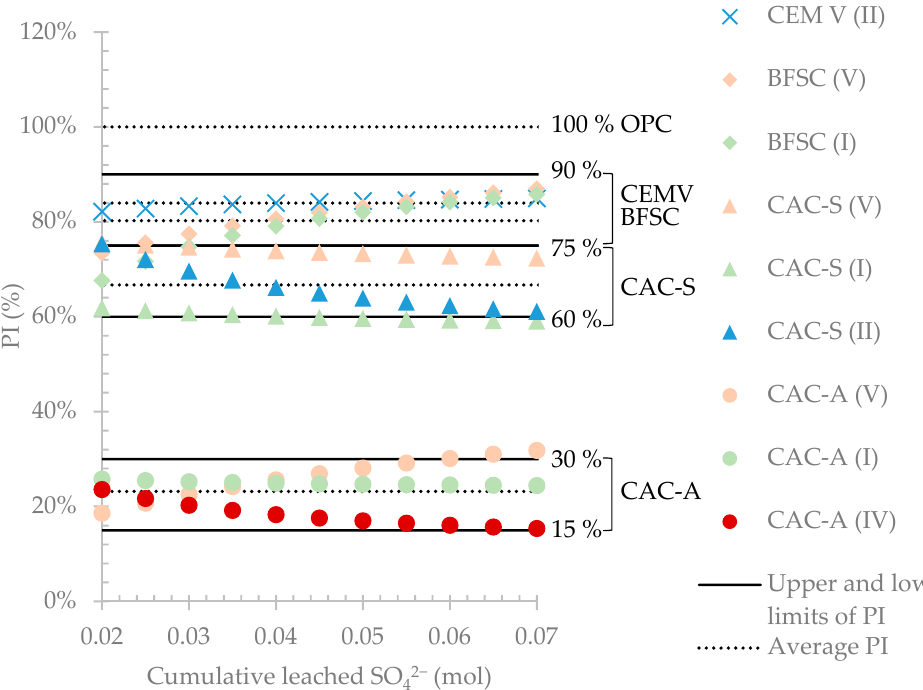
Figure 10. Evolution of the standardized cumulative leached calcium per square meter relative to the ordinary Portland material in the same campaign as function of the cumulative leached sulfate in the leached solution.